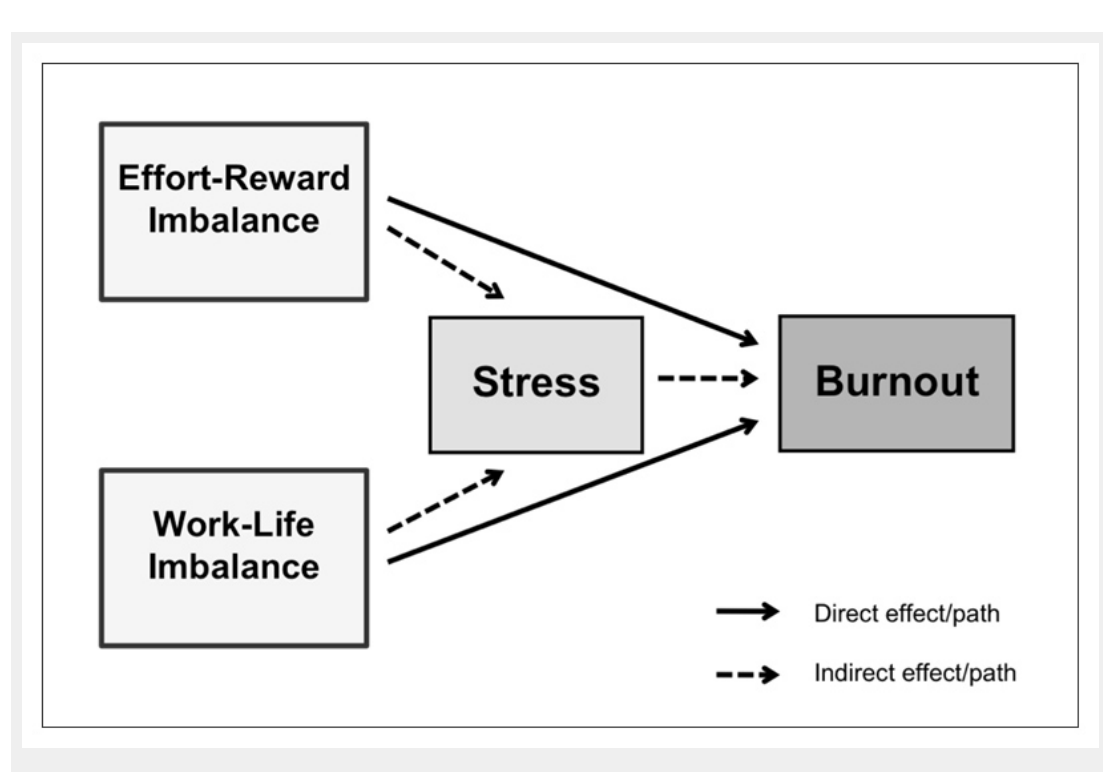
Figure 1 Conceptual path